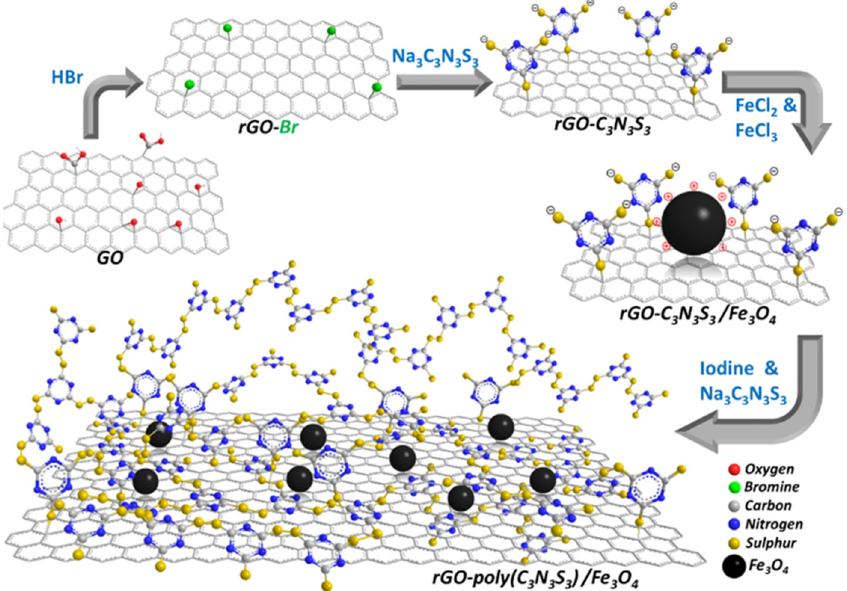
Figure 7. Schematic showing pathway for hybridization of GO with different compounds (Reproduced or adapted from ref. [42] , with permission from Elsevier, 2020).